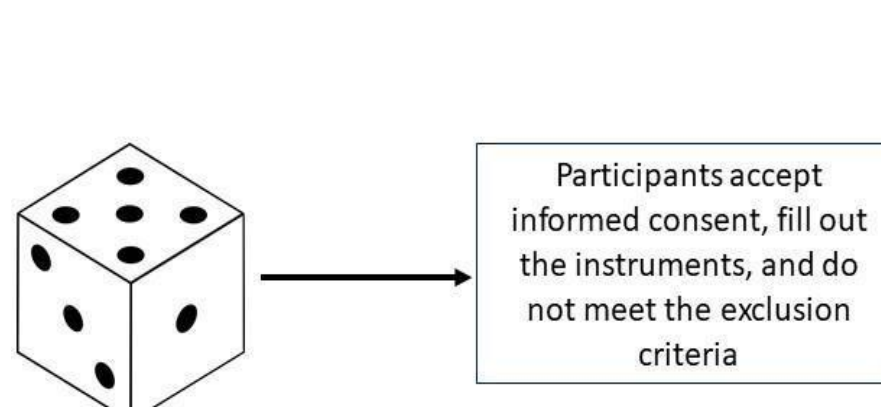
Figure 1. Randomization process.